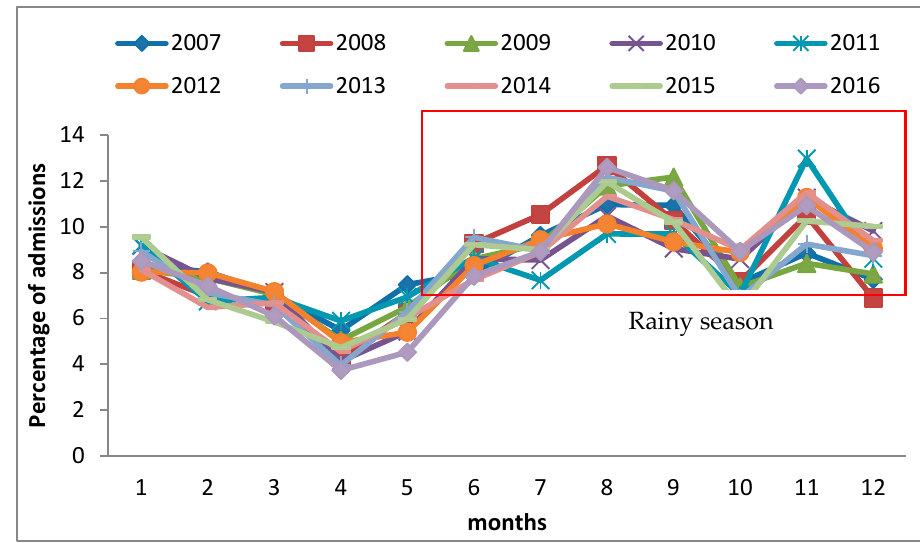
Figure 3. Seasonal variation in asthma-related hospital admissions rate by month.